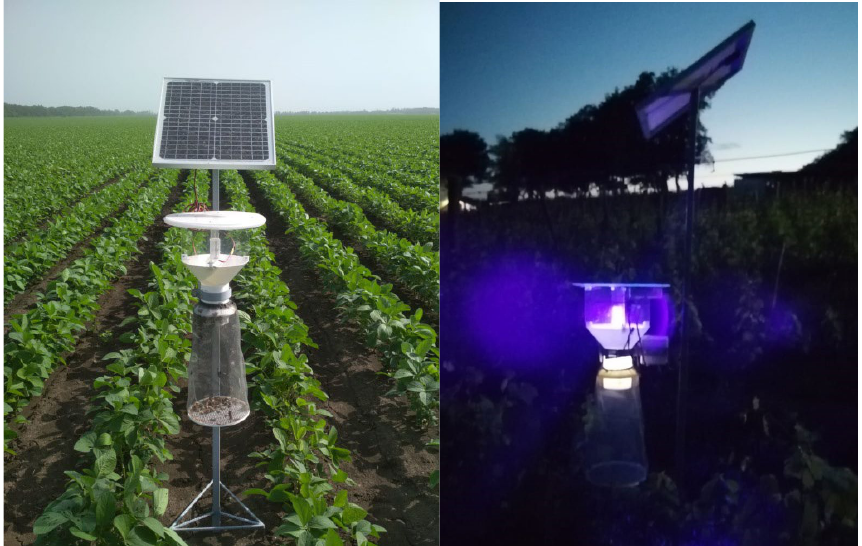
Figure 1. Light trap with a conical design (FRCBPP, Krasnodar, 2021).